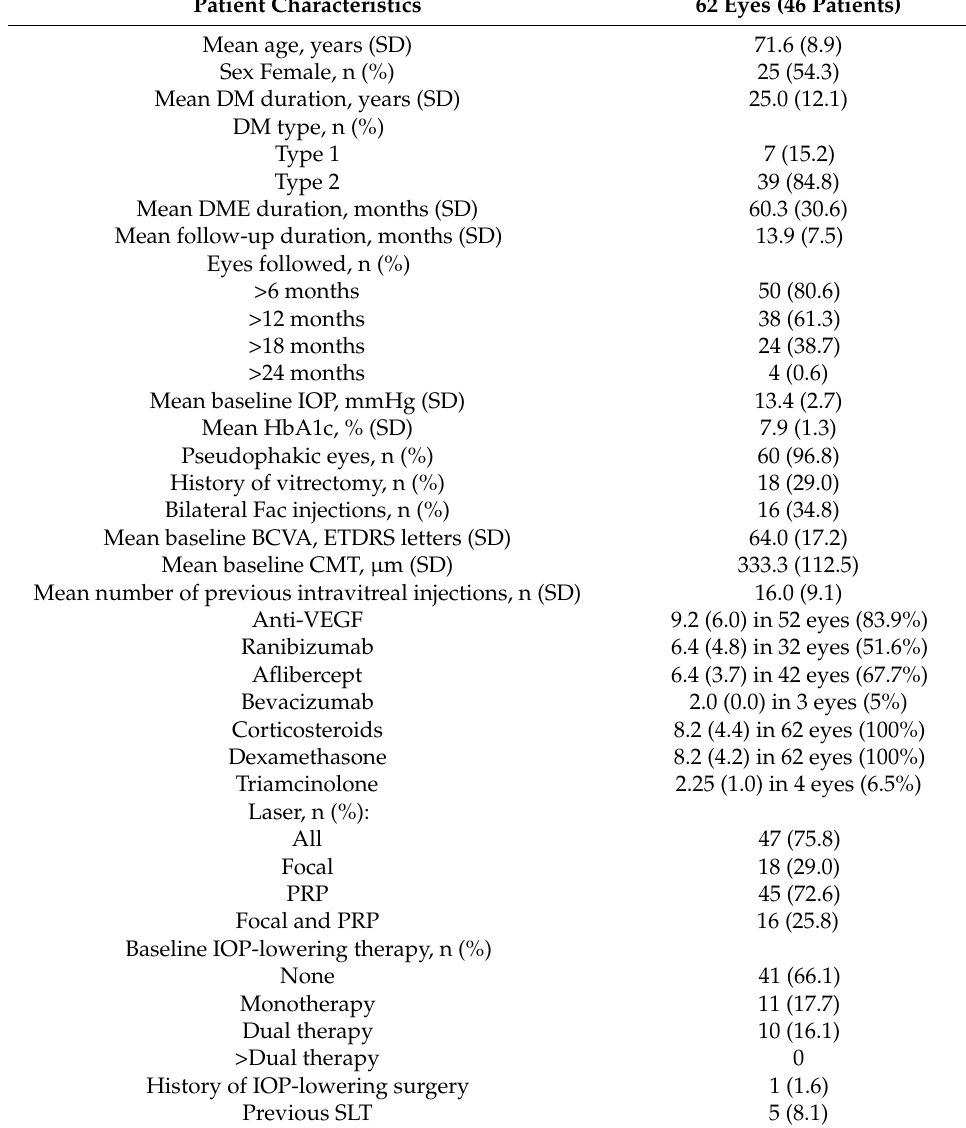
Table 1. Patient demographics and baseline